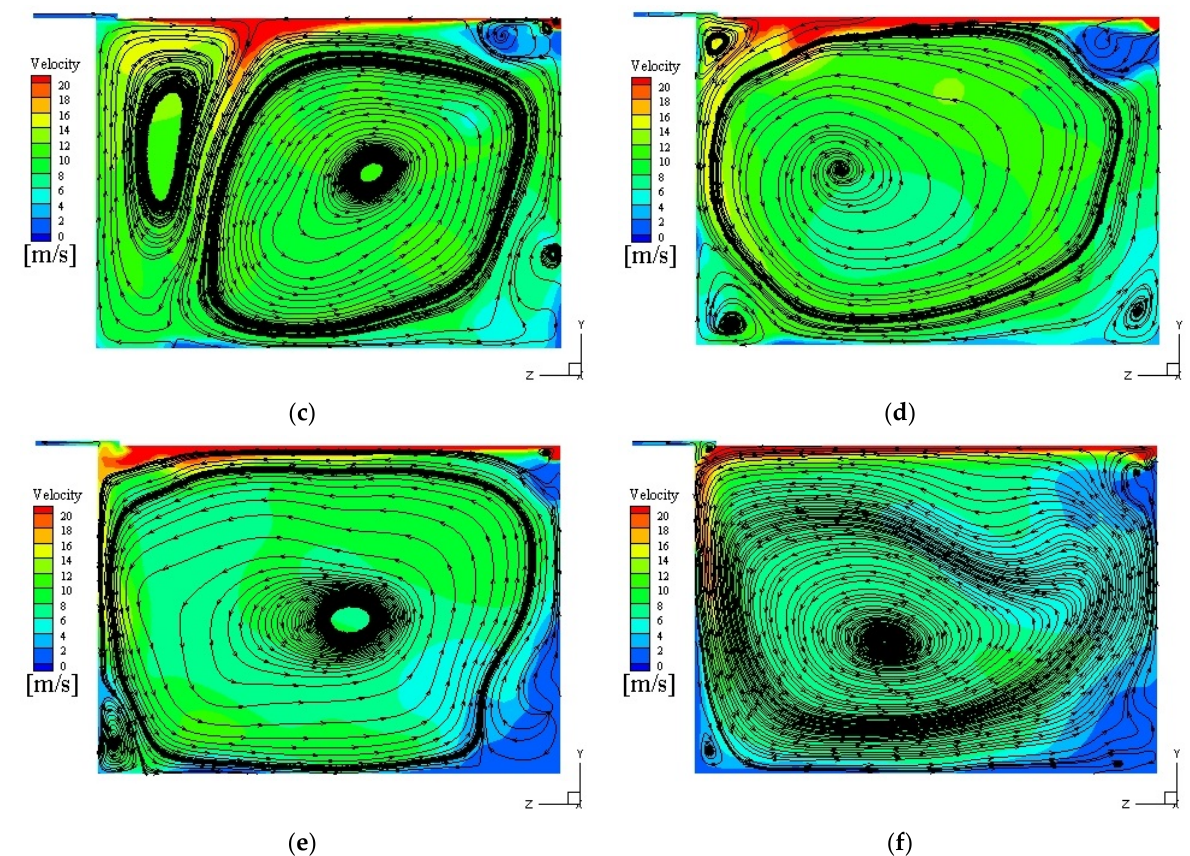
Figure 6. Streamlines and velocity field of oil/gas two-phase in the secondary flow with a cross section of 90° at 10,000 rpm over time: ( a ) T = 0.027 s; ( b ) T = 0.198 s;( c ) T = 0.363 s; ( d ) T = 0.393 s; ( e ) T = 0.528 s; ( f ) T = 1.117 s.